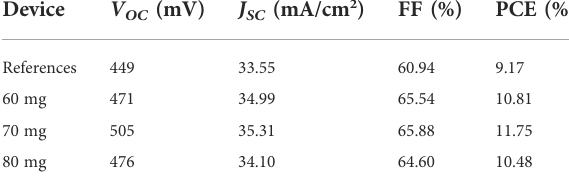
TABLE 1 Summary of the Photovoltaic Performances for CZTSSe devices with the absorber selenized under different